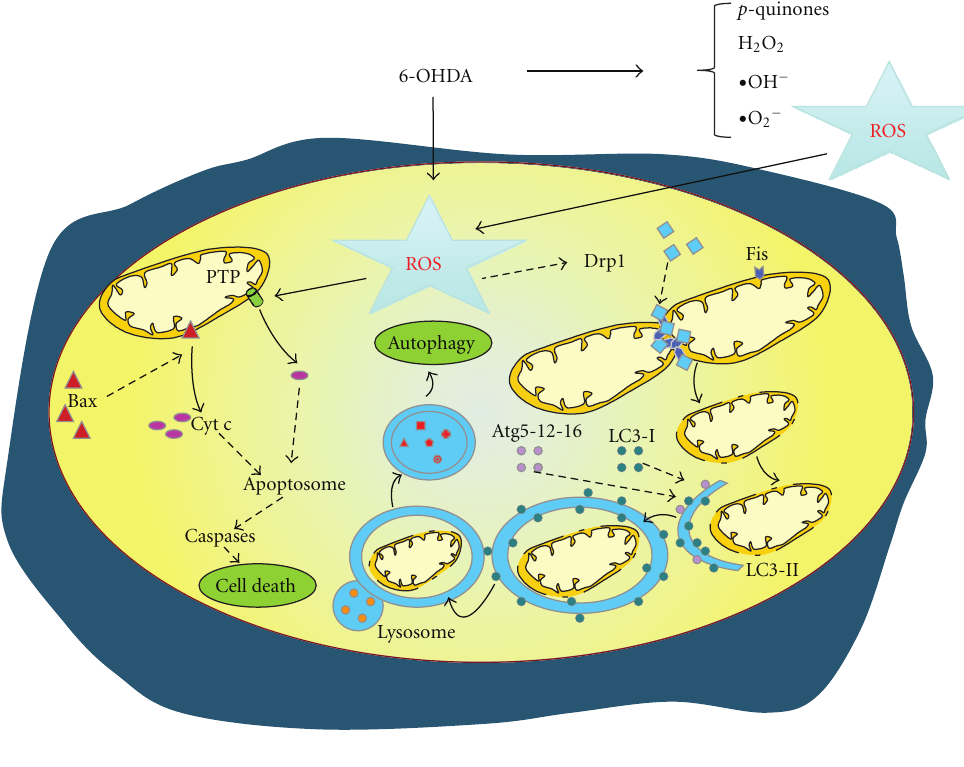
Figure 1: Mitochondrial fission and autophagy events are activated after 6-OHDA addition. Drp1 and Bax translocate from the cytosol to mitochondria. Drp1 has been proposed to encircle mitochondria to mediate constriction and this is followed by scission, which results in the formation of two separate mitochondria. Mitochondrial fission may play a role in the removal of dysfunctional mitochondria with reduced mitochondrial membrane potential, through an autophagy-lysosomal pathway named